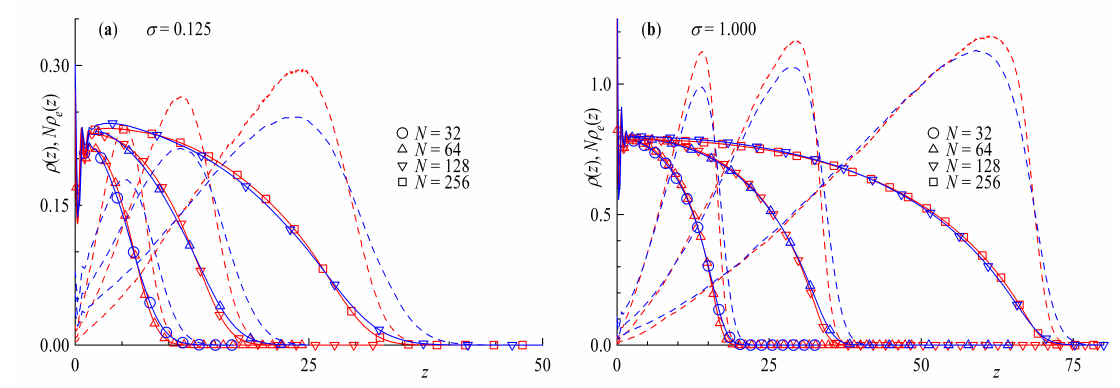
Figure 3. Density profiles ρ ( z ) and density profiles of end monomers for tails and middle monomers for rings multiplied by chain length N ρ e ( z ) as a function of distance from surface z for ( a ) surface coverage σ = 0.125 and ( b ) σ = 1.0 R g . Chain length N is given in different symbols shown. Red colors are rings and blue for tails.